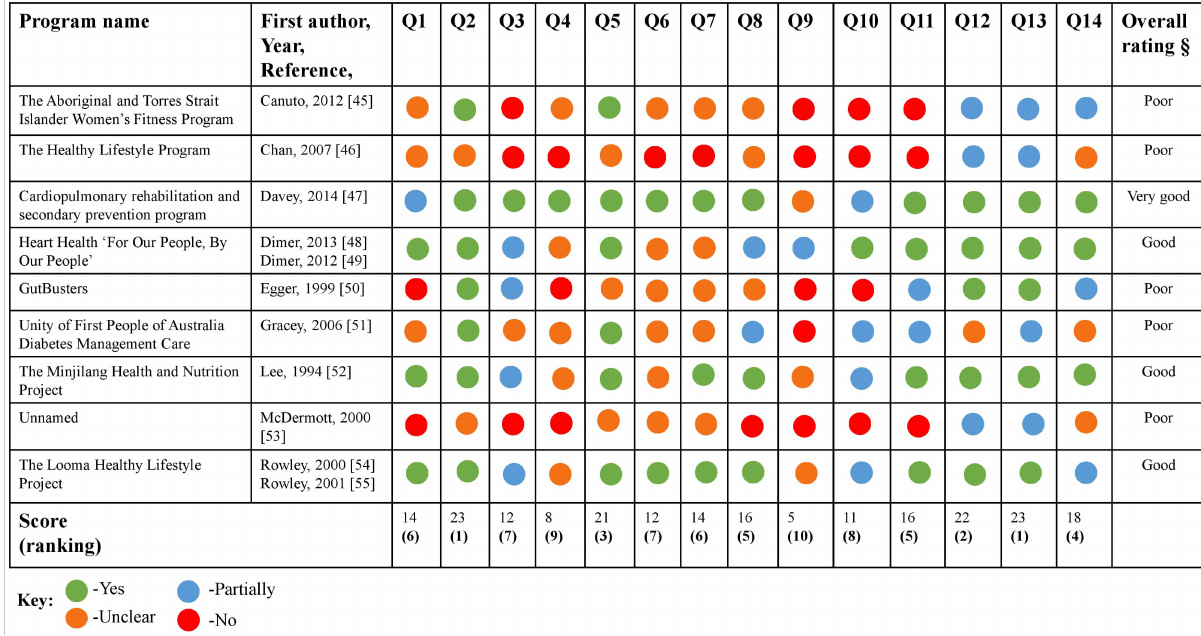
Figure 2. The 2018 SAHMRI CREATE Aboriginal and Torres Strait Islander Quality Appraisal Tool results of peer-reviewed programs presented as an adapted traffic light plot. Q1 Did the research respond to a need or priority determined